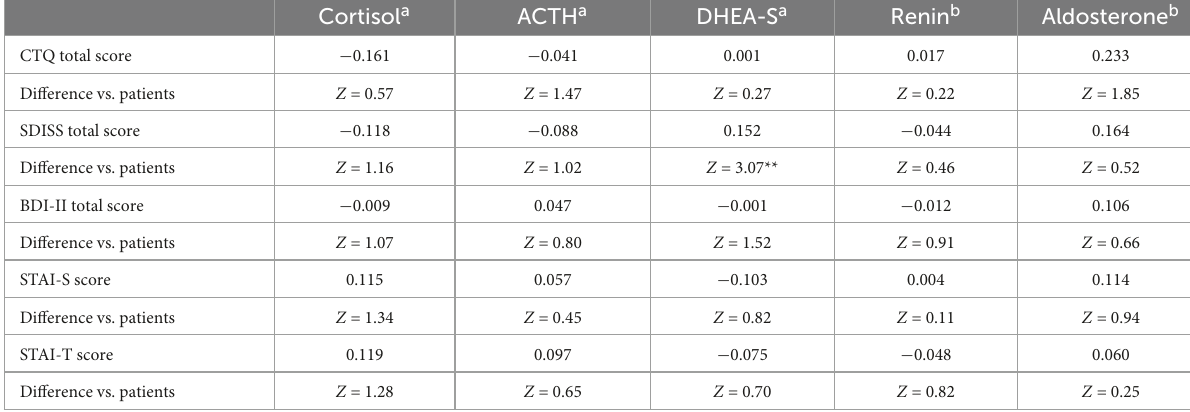
TABLE 4 Correlations of psychological characteristics with HPA axis and RAA system hormones in healthy controls (including differences in correlations between patients and controls). Cortisol a ACTH a DHEA-S a Renin b Aldosterone b −